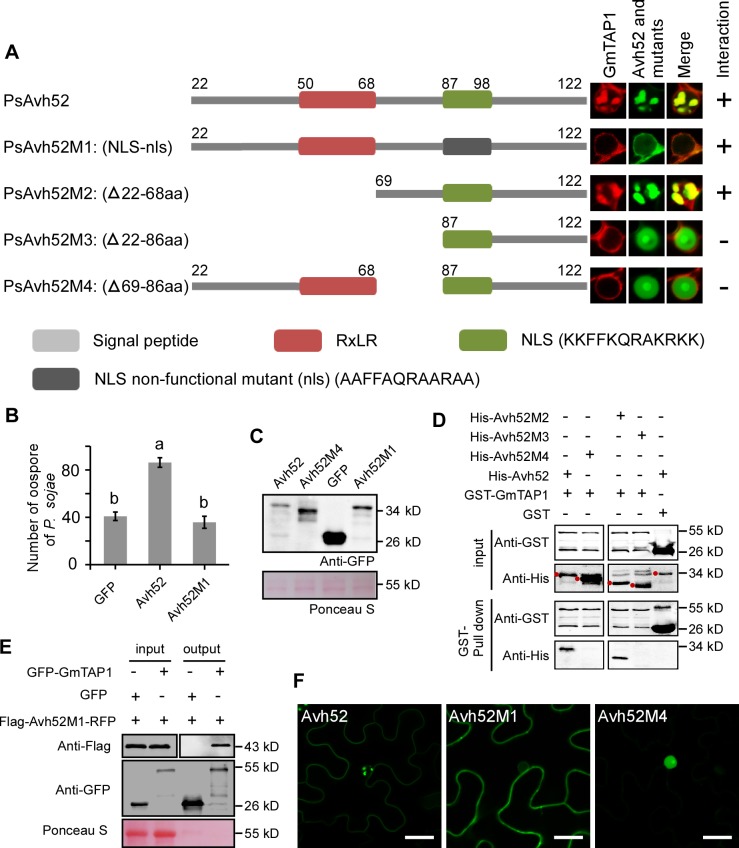
Residues 69 – 86 and the NLS (nuclear localization signal) of PsAvh52 are required for it to cause GmTAP1 to relocate into nuclear speckles.(A) Structures and co-localization with GmTAP1 of PsAvh52 and its mutants. The center three panels show the localization of GmTAP1-RFP and GFP-PsAvh52 (WT and mutant) proteins after 24 hr co-expression in N. benthamiana leaf cells. Rightmost column shows a summary of the interaction of PsAvh52 and its mutants with GmTAP1. (B) P. sojae oospore production 48 hr after inoculation of soybean hairy roots overexpressing GFP-Avh52M1, GFP-Avh52 or GFP. Data are the means ± s.d. of three independent experiments. Different letters on the graph show statistically significant differences from the samples (p < 0.01, Duncan’s multiple range test). (C) Western blot validation of protein levels of GFP, GFP-PsAvh52, GFP-PsAvh52M1 and GFP-PsAvh52M4 in soybean hairy roots, using anti-GFP antibodies. Total proteins were stained with Ponceau S. (D) The interaction of WT and mutants of PsAvh52 with GmTAP1 assayed using GST pull-downs. (E) Co-immunoprecipitation of PsAvh52M1 by GmTAP1 protein. Total proteins were extracted from N. benthamiana leaves co-expressing Flag-Avh52M1-RFP with GFP-GmTAP1 or GFP control. Immunoprecipitation (IP) was performed using GFP-Trap beads and the captured proteins were examined by western blot using anti-Flag antibody. (F) The localization of PsAvh52 and its mutants expressed alone in N. benthamiana leaf cells for 24 hr. Scale bars = 20 µm. Note that N. benthamiana expresses a GmTAP1 homolog which might bind to PsAvh52 and affect its localization.